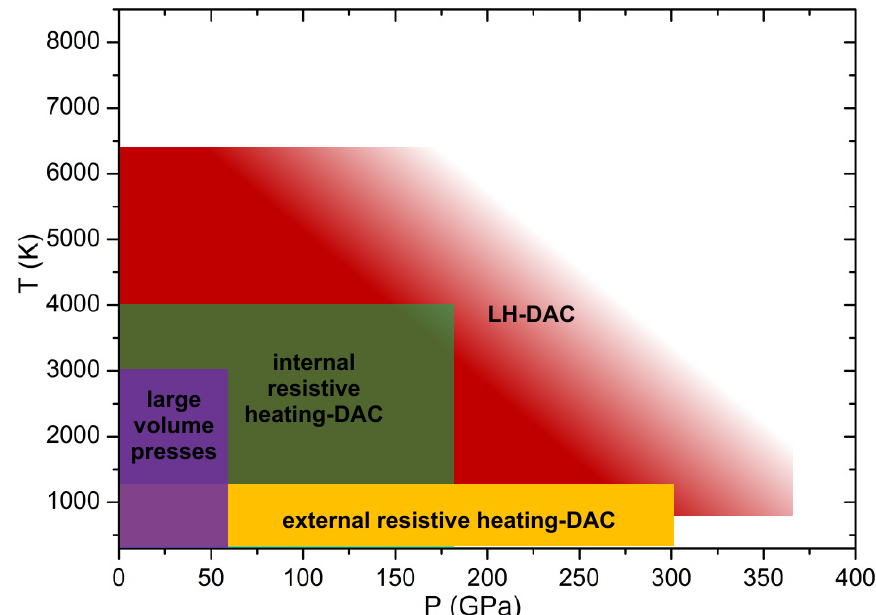
Figure 1. Comparison between the different P and T domains reachable using different static techniques. Large volume presses [42–46], including the Paris-Edinburgh cell, equipped with resistive heaters are a well-established static method to create high P-T environments. They allow large samples to be used (improving the signal/noise) but they are limited in the P-T range reachable. During external resistive heating in DAC, References [47–50] the entire DAC body is heated by Joule effect, providing a nice and uniform heating. However, such a configuration causes big thermal dispersion and mechanical instability, limiting the P-T range reachable with this technique. Internal resistive heating in DAC [51–58] provides advantages similar to the latter method, extending the reachable P-T range (as the heating is localized only to the high-pressure chamber of the DAC). Although the P-T limits of the internally heated DAC are constantly expanding, the laser-heating in DAC remains the only static technique allowing P-T in excess of 300 GPa and 6000 K